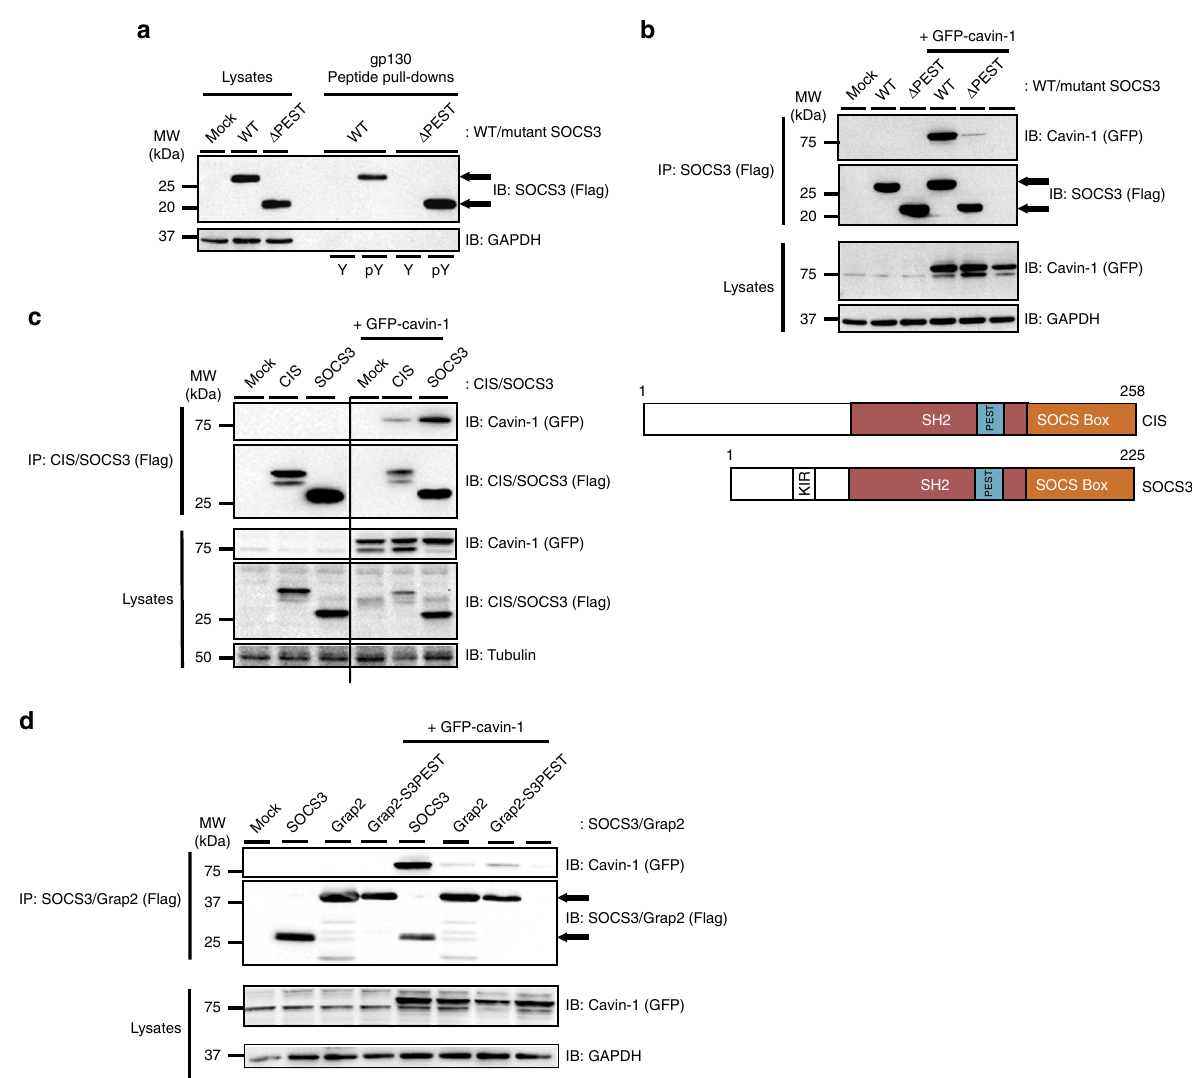
Fig. 5 Cavin-1 – SOCS3 interaction requires the SOCS3 SH2 PEST motif. a Protein-equalised soluble cell extracts from HEK293 cells transfected with expression constructs encoding either WT or Δ PEST Flag-SOCS3 were incubated with 100 nM N-terminally biotinylated peptides corresponding to the Tyr759 motif of gp130 in its phosphorylated (pY) or non-phosphorylated (Y) forms and streptavidin – agarose beads prior to loading with whole-cell lysate samples for SDS-PAGE and immunoblotting with the indicated antibodies. b Protein-equalised soluble cell extracts from HEK293 cells transfected with expression constructs encoding either WT or Δ PEST Flag-SOCS3 and GFP-tagged cavin-1 as indicated were processed by IP with anti-Flag M2-agarose beads prior to SDS-PAGE and immunoblotting with the indicated antibodies. Whole-cell lysates from the samples used in the IP were also fractionated by SDS-PAGE for immunoblotting in parallel. c Upper, Protein-equalised soluble cell extracts from HEK293 cells transfected with or without the indicated CIS and SOCS3 expression constructs and GFP-tagged cavin-1 as indicated were processed by IP with anti-Flag M2-agarose beads prior to SDS-PAGE and immunoblotting with the indicated antibodies. Whole-cell lysates from the samples used in the IP were also fractionated by SDS-PAGE for immunoblotting in parallel. Lower, Schematic of CIS and SOCS3. d Protein-equalised soluble cell extracts from HEK293 cells transfected with or without the indicated SOCS3 and Grap2 expression constructs and GFP-tagged cavin-1 as indicated were processed by IP with anti-Flag M2-agarose beads prior to SDS-PAGE and immunoblotting with the indicated antibodies. Whole-cell lysates from the samples used in the IP were also fractionated by SDS-PAGE for immunoblotting in